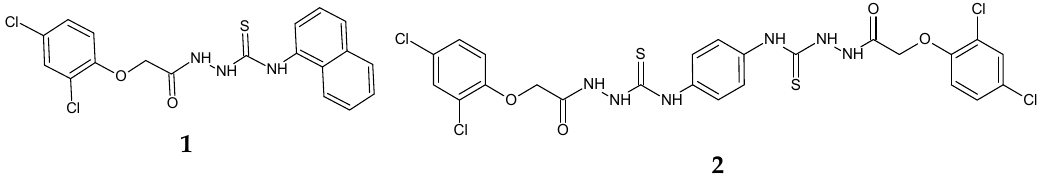
Figure 1. Structure of tested compounds.